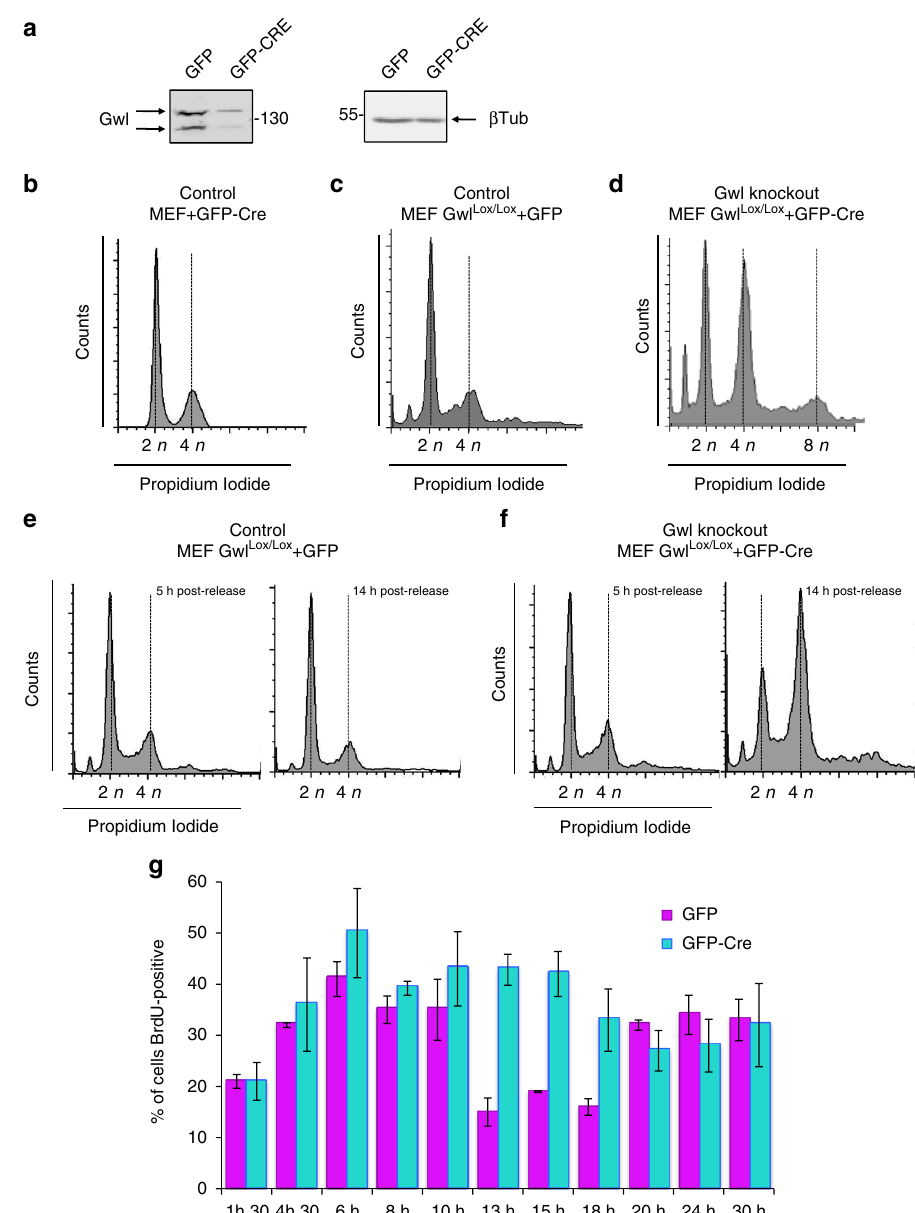
Fig. 5 The knockout of Greatwall, the upstream kinase of Ensa, also results in partial S-phase accumulation. a Control or MEF Gwl(Lox/Lox) cells were serum-starved for 3 days, infected for 5 h with GFP or GFP-Cre-expressing adenoviruses as indicated, stimulated to re-enter the cell cycle with fresh serum-supplemented media and recovered for western blot with the indicated antibodies. b FACS analysis 48 h after infection in control MEFs infected with GFP-Cre adenoviruses. c Gwl Lox/Lox MEFs infected with control GFP adenovirus. d Gwl Lox/Lox MEFs infected with GFP-Cre adenovirus. e MEF Gwl Lox/Lox cells were serum-starved for 3 days and subsequently infected with GFP-expressing adenovirus. Five hours later, cells were supplemented with fresh medium containing aphidicolin for 24 h. S-phase synchronised cells were then released and recovered at 5 and 14 h for FACS analysis. f As for e , except that GFP-Cre-expressing adenoviruses was used. g S-phase synchronised cells infected with GFP (control) and GFP-Cre (Gwl knockout) adenoviruses as in e and f were released and a pulse of 30 min of BrdU at the indicated time points was performed. Cells were then fi xed and immunostained with anti-BrdU antibodies. The number of S-phase cells in control and Gwl knockout cells were counted at each time point, compared and represented as a bar graph of the mean value of three different samples ± standard deviation. A cell number between 175 and 565 were counted for each time